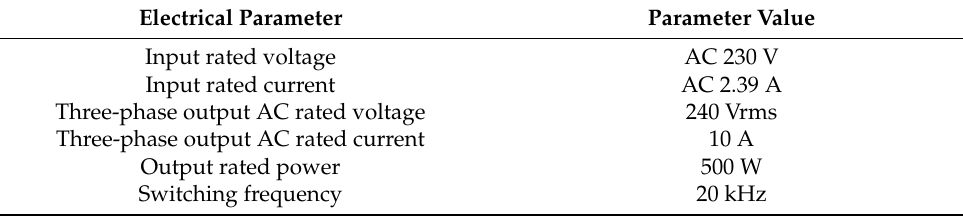
Table 3. Specifications of compressor of refrigerated cabinets.